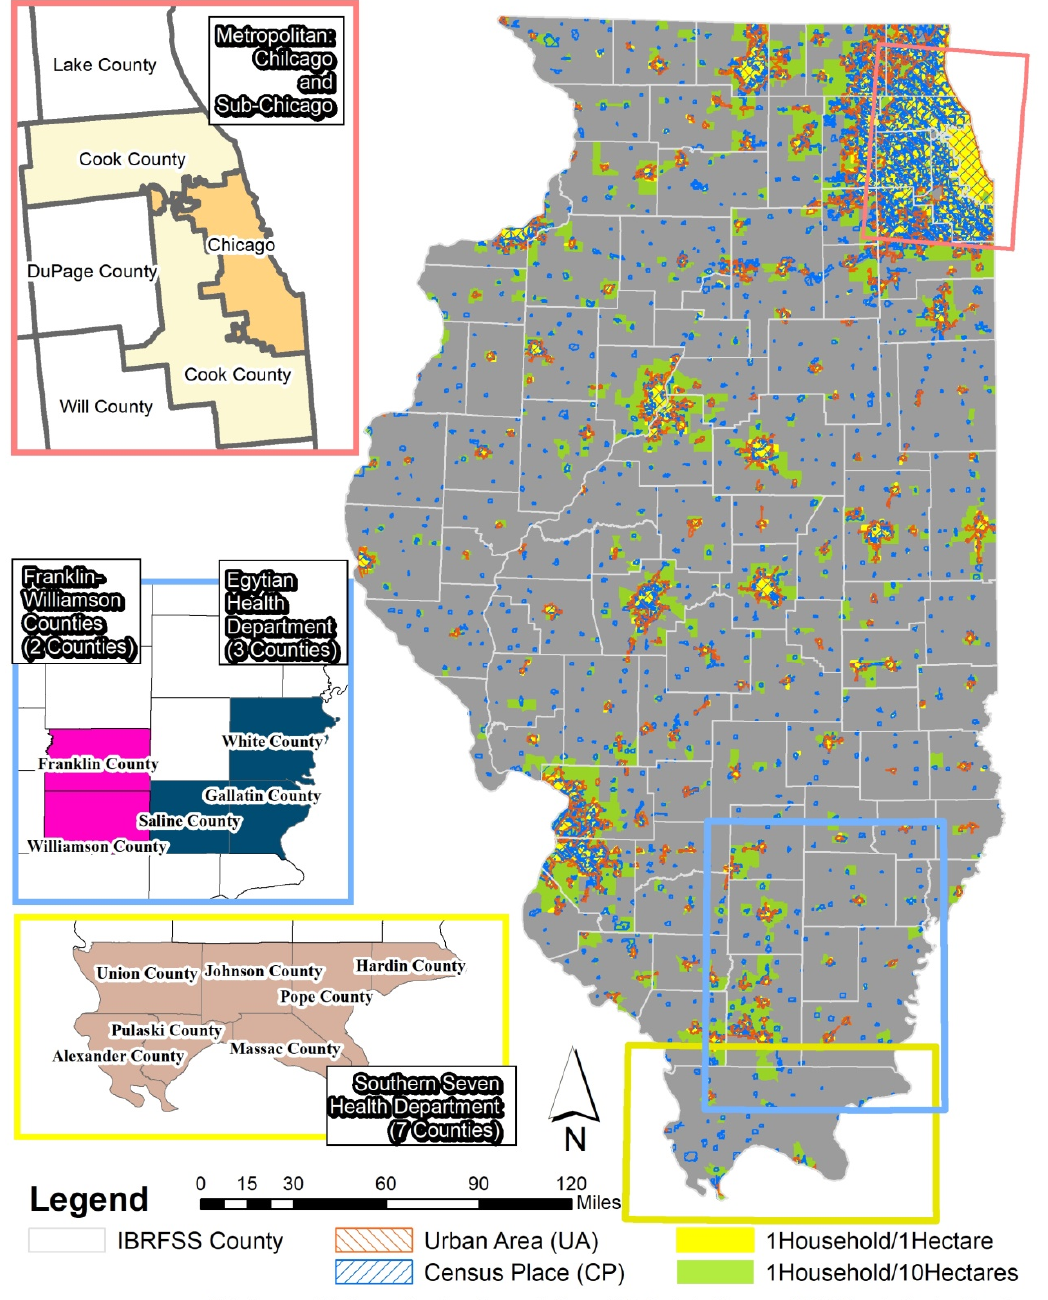
Figure 1. Selected counties in Illinois County Behavioral Risk Factor Surveys (ICBRFS) and spatial boundaries to identify community green space in the study area.